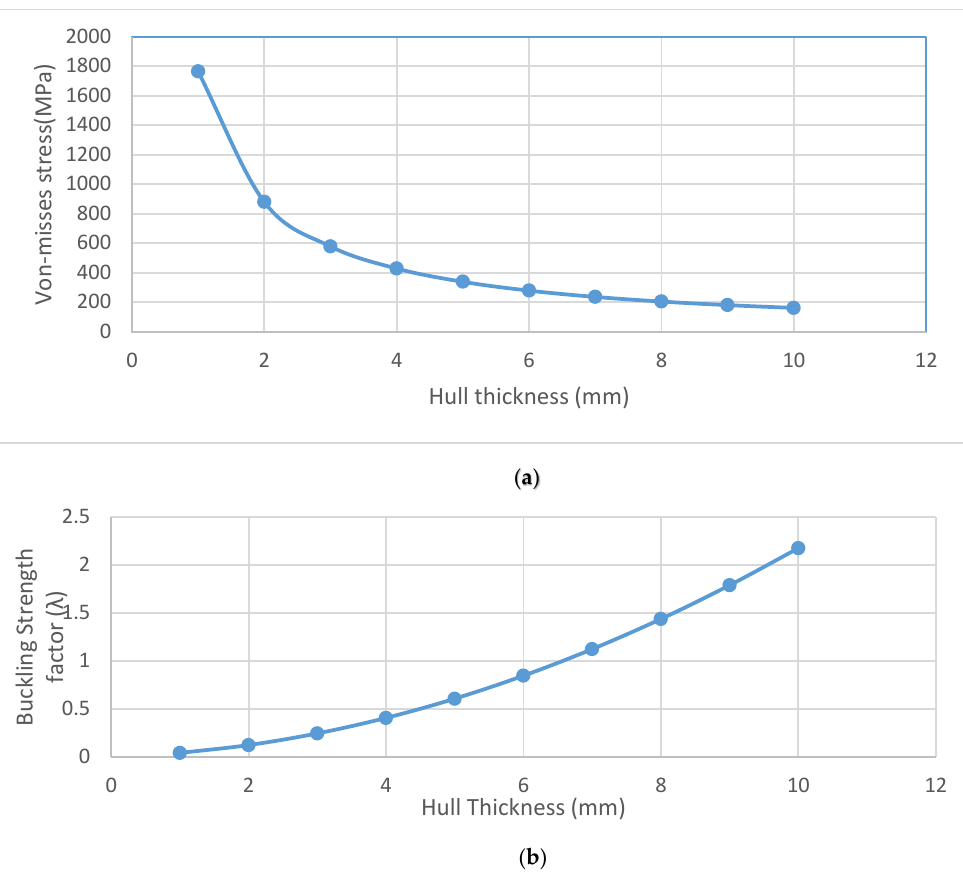
Figure 6. ( a ) hull thickness vs. Von-misses stress. ( b ) Hull thickness vs. Buckling Strength Factor (λ) .